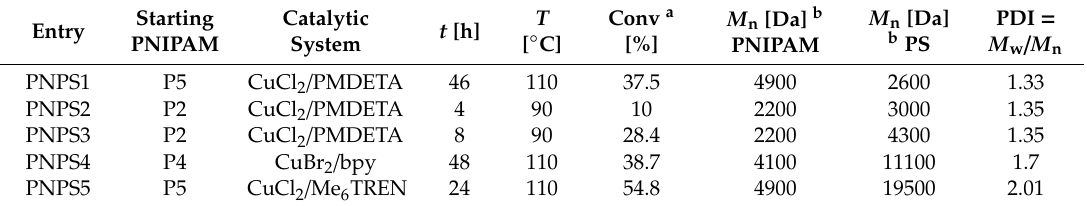
Table 3. The conditions under which the chain extensions of PNIPAM-Br with styrene via ARGET ATRP were conducted; the obtained monomer conversions (Conv), number-averaged molecular masses ( M n ) of both blocks in the polymers’ chains and polydispersity indices determined from SEC